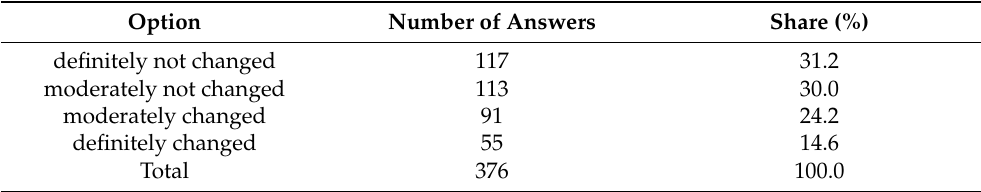
Table 2. Results answers to the following question: Has your recreational activity in UGS and forests increased during the pandemic (compared to the time before the pandemic)?